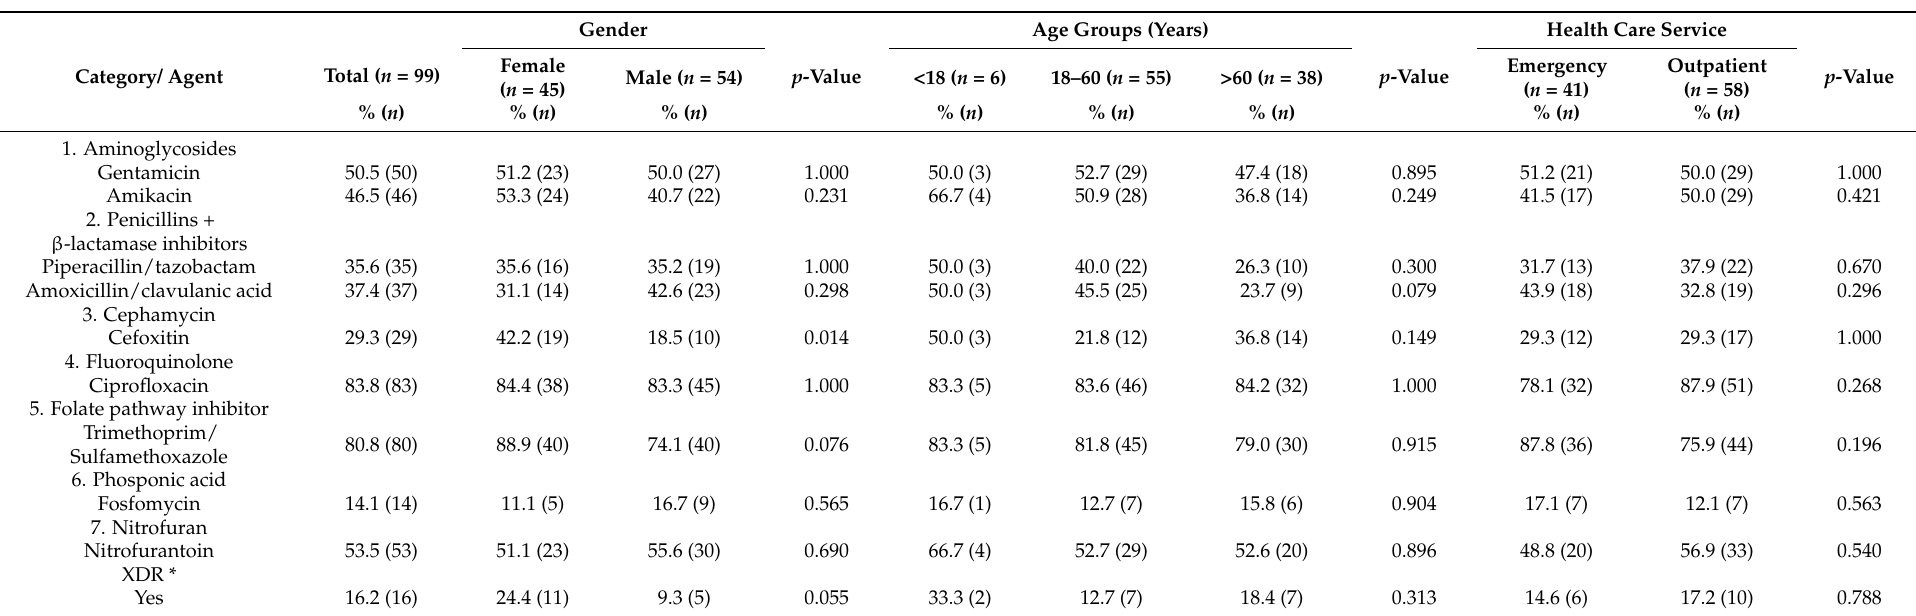
Table 1. Antibiotic resistance rates of ESBL-producing uropathogenic E. coli according to patients’ gender, age groups, and healthcare